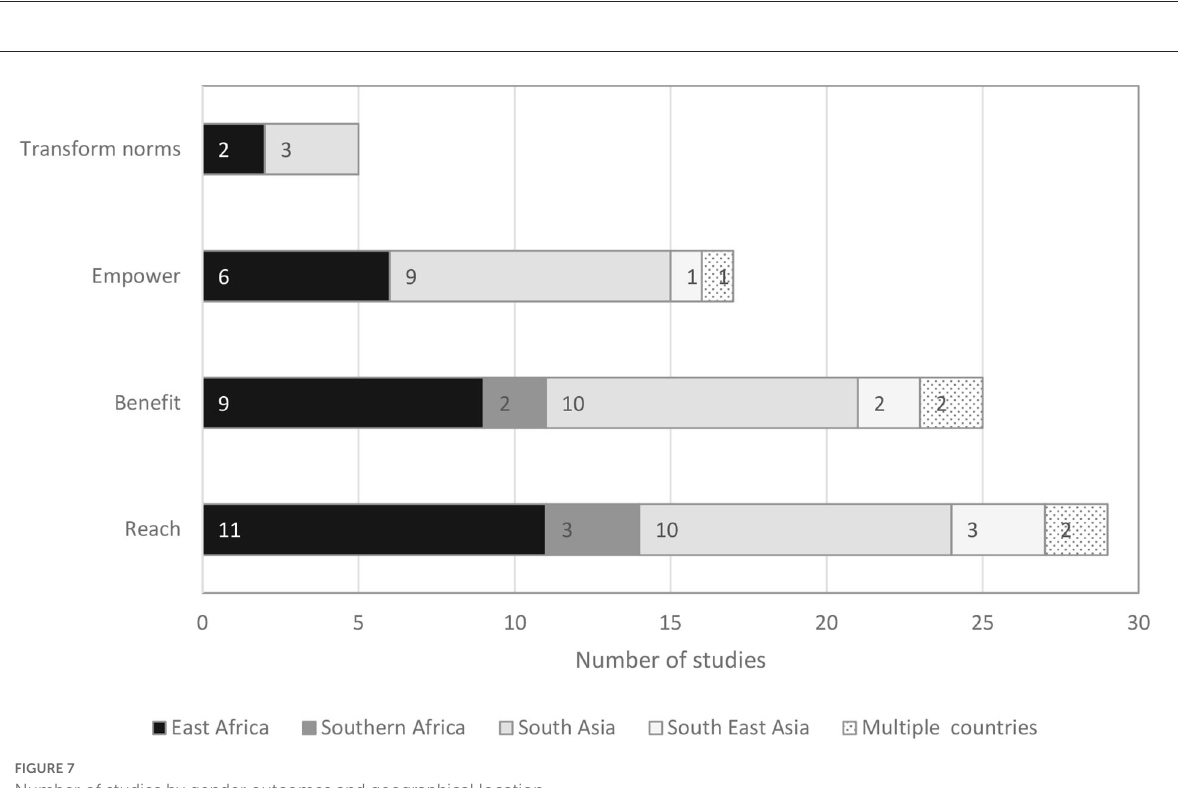
FIGURE7 Number of studies by gender outcomes and geographical